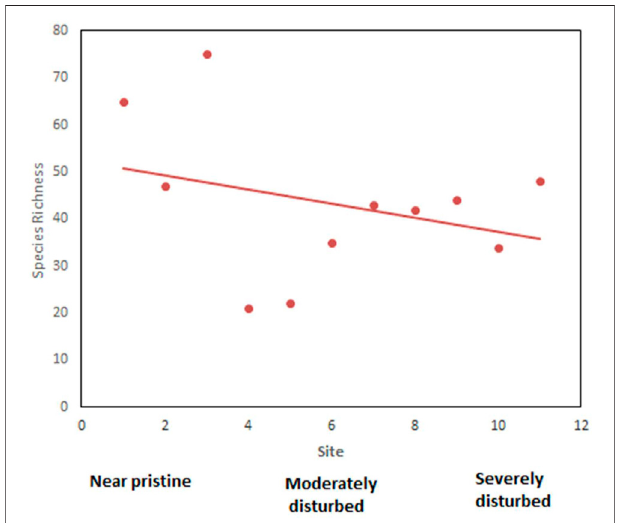
FIGURE 10 | The relationship between species richness and habitat disturbance species richness declined progressively from undisturbed sites (1 – 3), through moderately disturbed sites (4 – 8) to severely disturbed sites (9 – 12).